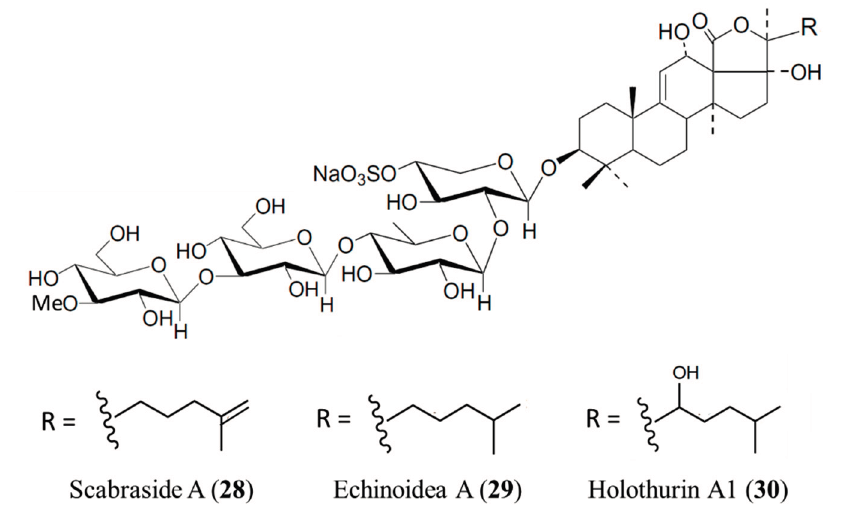
Figure 8. Scabraside A ( 28 ), echinoidea A ( 29 ), and holothurin A1 ( 30 ), isolated from Holothuria scabra